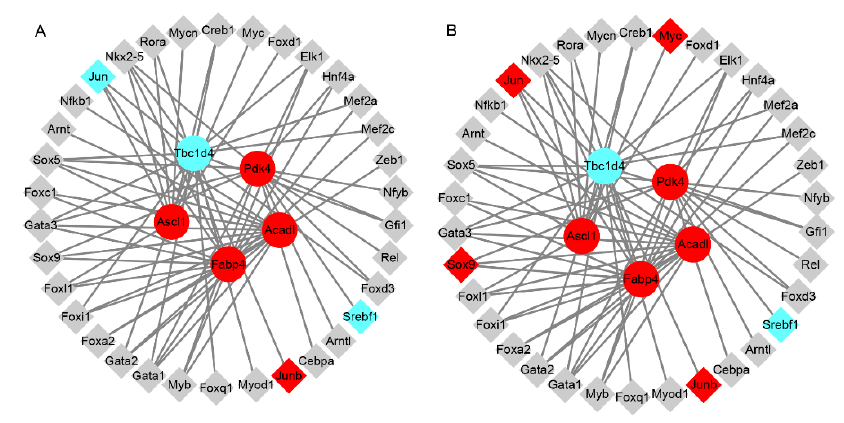
Figure 5. The network of Acadl , Acsl1 , Fabp4 , Pdk4 and Tbc1d4 and their dysregulated transcription factors (TFs). ( A ) The network of Acadl , Acsl1 , Fabp4 , Pdk4 and Tbc1d4 and their dysregulated TFs at three weeks. ( B ) The network of Acadl , Acsl1 , Fabp4 , Pdk4 and Tbc1d4 and their dysregulated TFs at four weeks. Grey represents the genes expressed without significant difference; cyan represents the downregulated expression of genes; and red represents the upregulated expression of genes. The circled genes represent the target genes of the TFs, while the diamonds represent the individual TFs.